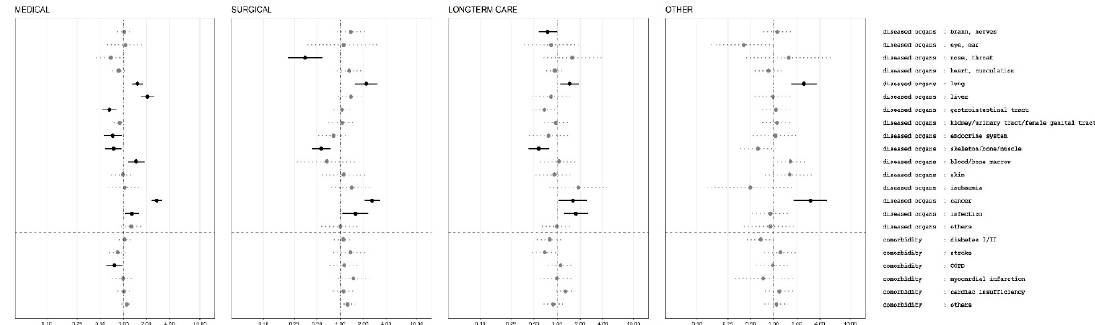
Figure 5. Multivariate analysis of association between organ related disease categories from ICD 10 as well as comorbidities and death in hospital within 30 days after nutritionDay for medical, surgical, long-term care and other patient groups with the general linear model for logistic regression with wards as clusters and weighting of individual patients for sampling probability [25] and including demographic and nutrition related risk factors (see Figure 4). Odds ratios (OR) with 95% confidence intervals indicated by horizontal line. Multiple entries are possible. Missing values are included in the model as individual categories.